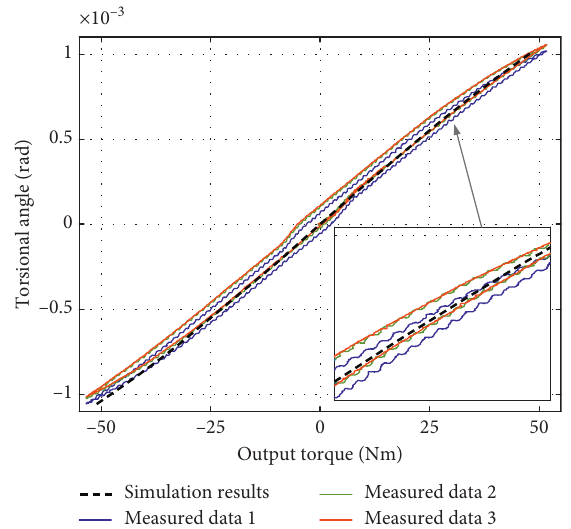
Figure 6: Measured stiffness curve and simulation results of stiffness